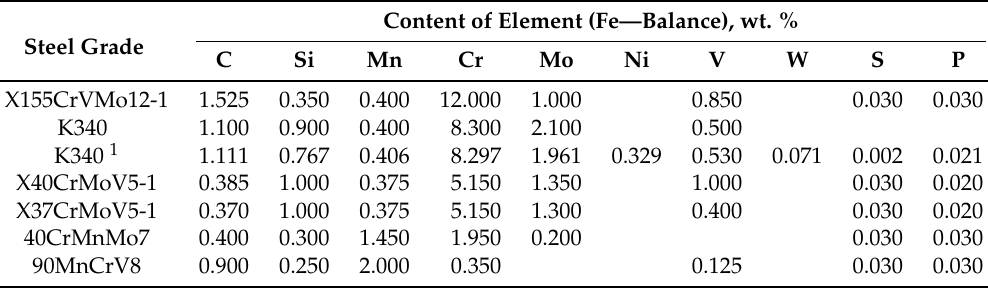
Table 2. Chemical composition of the tested K340 steel and the set of reference tool steels.